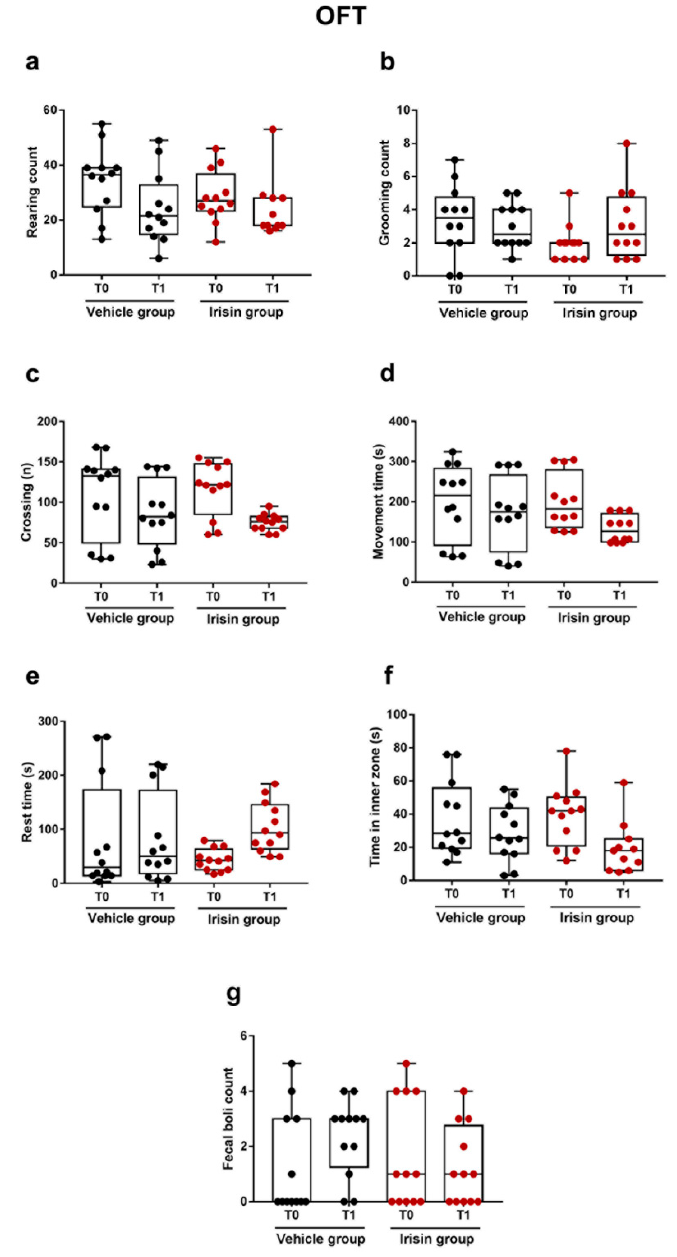
Figure 1. Effect of short-term systemic administration of irisin on the rearing count ( a ), grooming ( b ), crossing ( c ), movement time ( d ), rest time ( e ), time spent in inner zone ( f ), and fecal boli count ( g ) in the OFT before treatment (T0) and after two hours (T1) at day 5. Shapiro–Wilk test and unpaired Kruskal–Wallis test were used for statistical analysis. Data are presented as box-and-whisker with median and interquartile ranges, from max to min, with all data points shown. n = 12 mice per